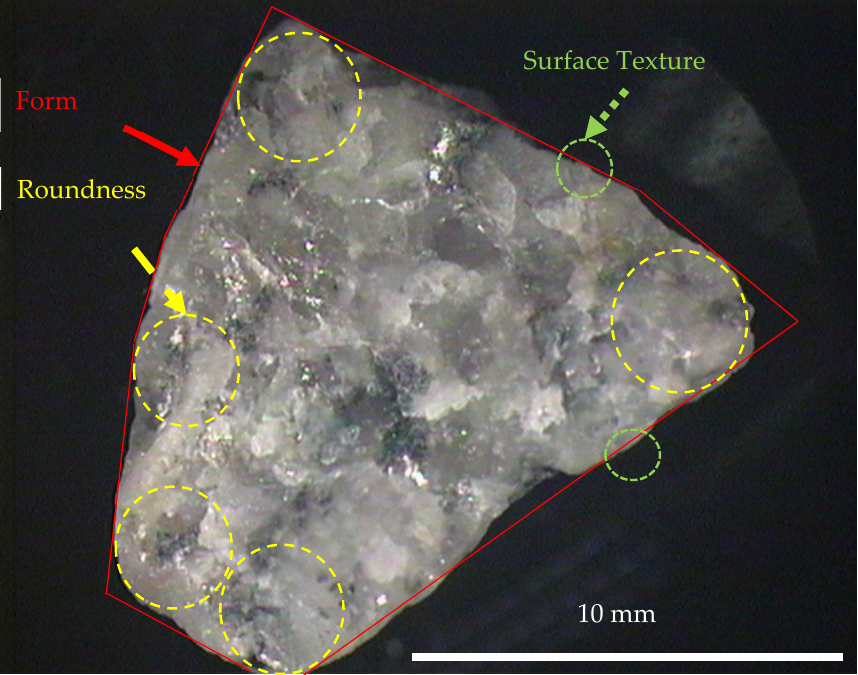
Figure 2. Coarse quartz particle with different morphological features annotated according to the classical categorization of Barrett.